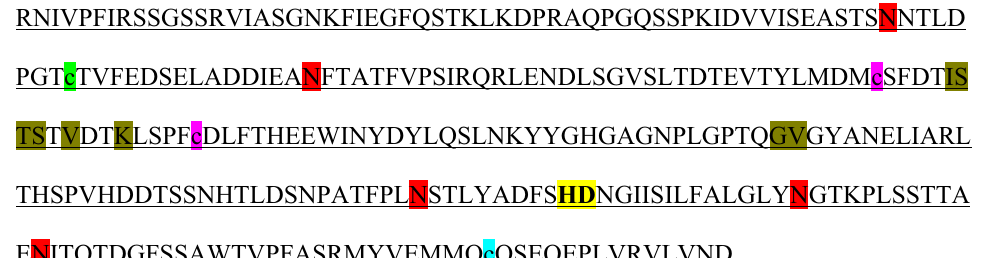
Table 3 Derived 391 partial amino acid sequences showing 3 predicted intra chain disulphide bond locations denoted in small letter case (c) and in different highlight colors, 8- N glycosylation sites with red high lights and 11- O glycosylation sites and location of catalytic domain of the enzyme with bold and yellow high lights YQcFSETSHLWGQYAPFFSLANKSAISPDVPAGcHVTFAQVLS RH GA R YPT D SKGKK YSALIEEIQQNATTFEGKYAFLKTYNYSLGADDLTPFGEQELVNSGVKFYQRYESLT